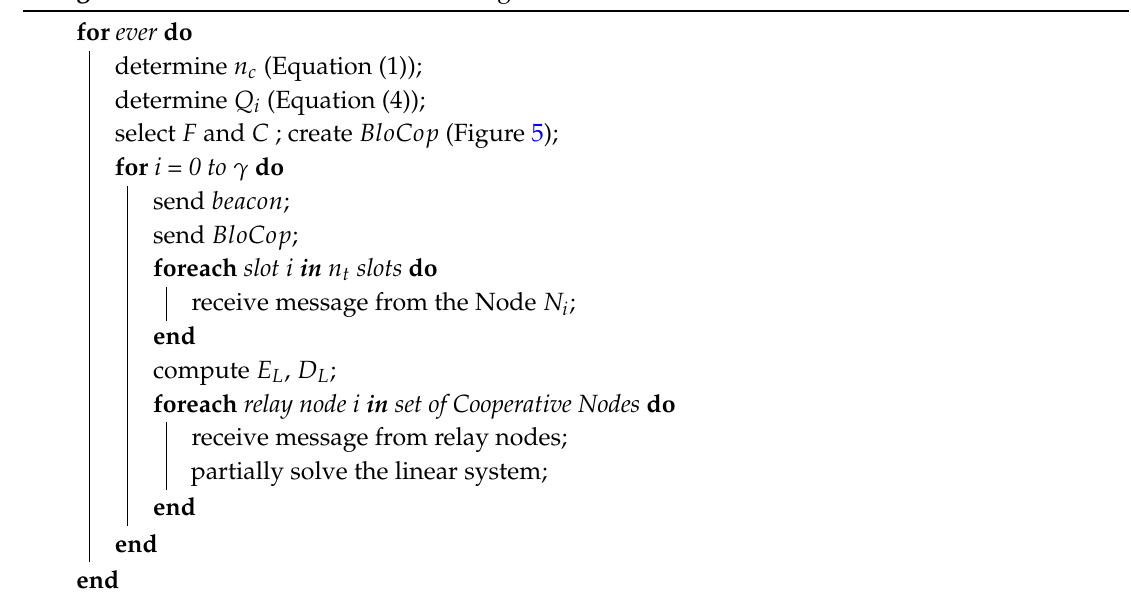
Algorithm 1: Overview of coordinator